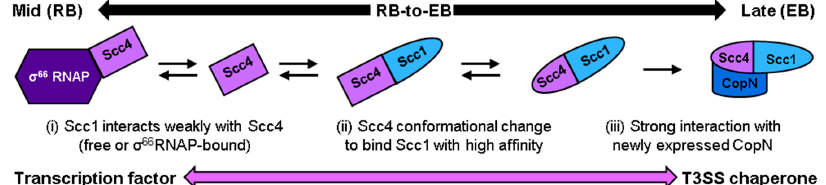
Figure S1: Expression and purification of 15 N-labeled Scc4:His 6 -Scc1, Figure S2: Expression and purification of 15 N-labeled His 6 -Scc4:Scc1-FLAG, Figure S3: Overlay of the 1 H- 15 N HSQC spectra of the in vivo-associated, 15 N-labeled protein complexes, Figure S4: Full gel images of the native gels from Figure 4A, Figure S5: 1 H, 15 N-HSQC spectra of 15 N-Scc4 titrated with Scc1-FLAG, Figure S6: 1 H, 15 N-HSQC peak changes during the Scc1-FLAG titration of Scc4 mapped on the Scc4 homology model, Figure S7: SDS-PAGE analysis of the His 6 -Scc1 inclusion body purification, Figure S8: Full gel images of the native gels from Figure 6A, Figure S9: SDS-PAGE analysis of the renatured and chain-selectively labeled Scc4:His 6 -Scc1 complexes, Figure S10: Phyre2 alignment of CT Scc4 and Yersinia pestis YscB from PDB 1XKP, chain C, Figure S11: Phyre2 alignment of CT Scc1 and Yersinia pestis SycN from PDB 1XKP, chain B, Figure S12: Phyre2 alignment of CT CopN and Yersinia pestis YopN from PDB 1XKP, chain A, Figure S13: Scc4 homology model with Scc1 interface and overlapping